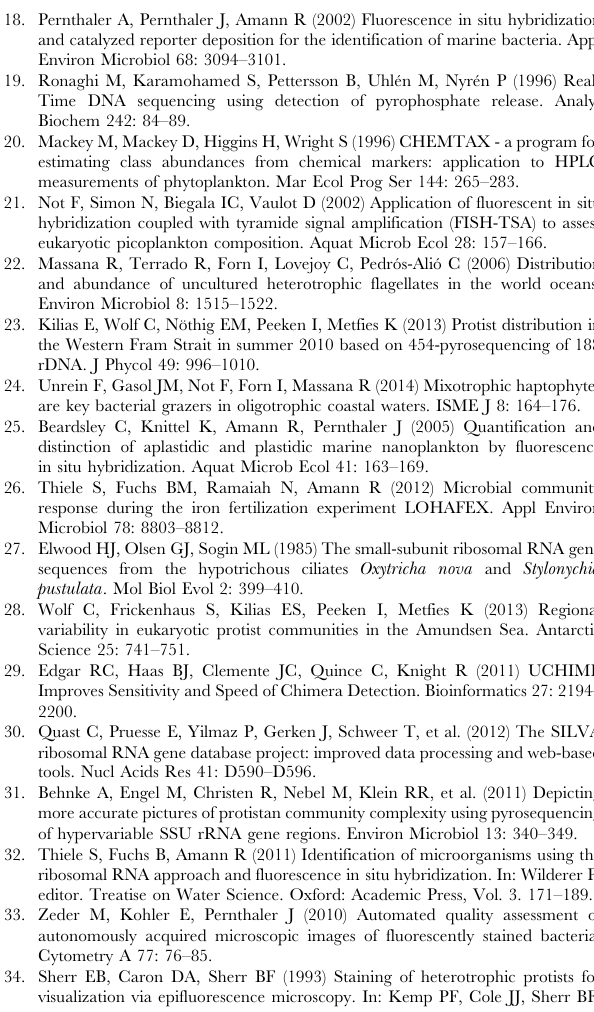
Figure S3 18S rRNA-based tree reconstruction of the Mamiellales clades. Values in the wedges represent the number of reference sequences, while values behind the clades show the abundance of LOHAFEX sequences in these clades The tree was build using the ARB SILVA ref 119 database [30], calculated using Neighbour Joining and Maximum Likelihood algorithms. The aligned consensus tag sequences were added with parsimony criteria to the trees and percentage of tags falling into the respective clade are given behind the clades. Values in the wedges represent the number of reference sequences. Scale bar represents 1% estimated base substitution.